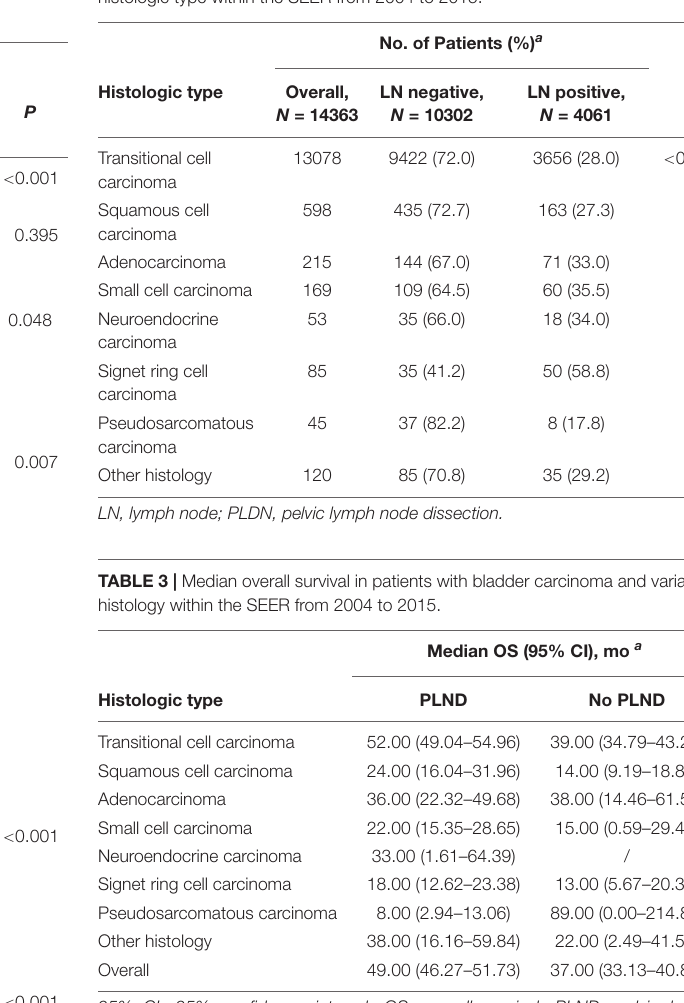
TABLE 2 | Lymph-Node-Positive disease at cystectomy and PLND in each histologic type within the SEER from 2004 to 2015.